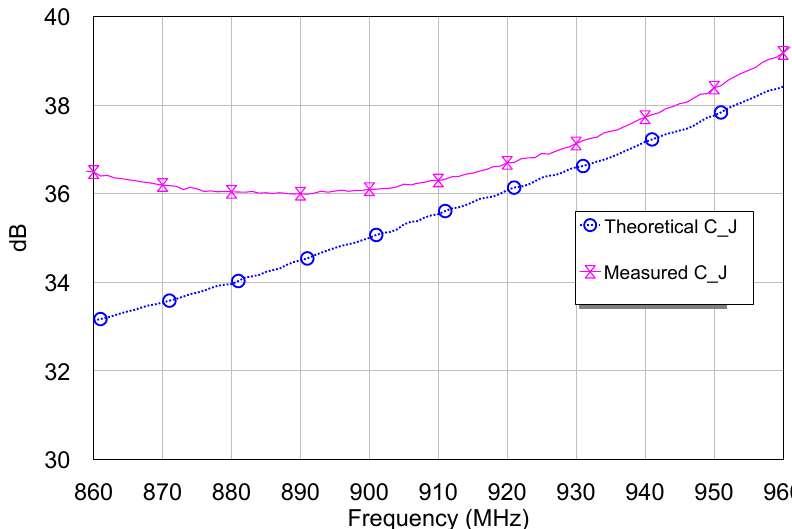
Figure 16. Experimental and simulated carrier over jammer